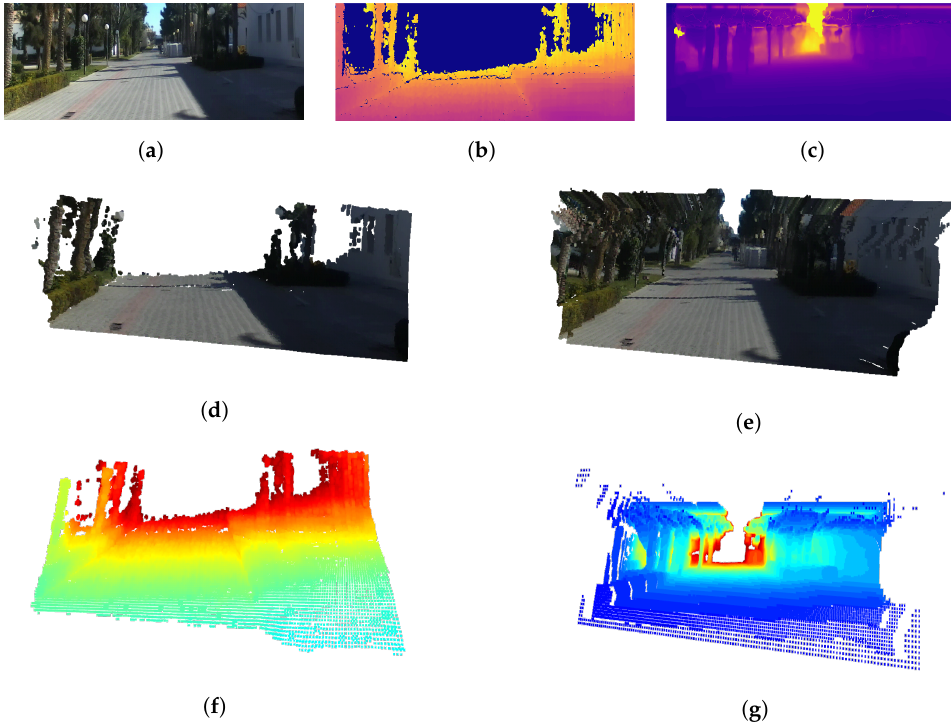
Figure 8. 3D reconstruction results using UASOL dataset. ( a ) RGB, ( b ) stereo depth, ( c ) mono depth, ( d ) stereo depth mesh, ( e ) depth fusion mesh, ( f ) stereo depth voxel, and ( g ) depth fusion